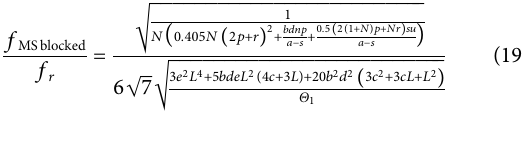
This ratio is plotted in terms of the number of internal oscillators N in Figure 4, while other parameters are taken from Table 1, as de fi ned in [22]. In addition, Poisson ’ s ratio ] needed for Eq. 1 is 0.3. It should be noted that this ratio does not depend on the ratio ( E / ρ ) 1/2 . For the ratio de fi ned by Eq. 19 to be equal to unity and satisfy the tuning condition, the theoretical analysis shows that N needs to be equal to 8, as labeled in Figure 4.